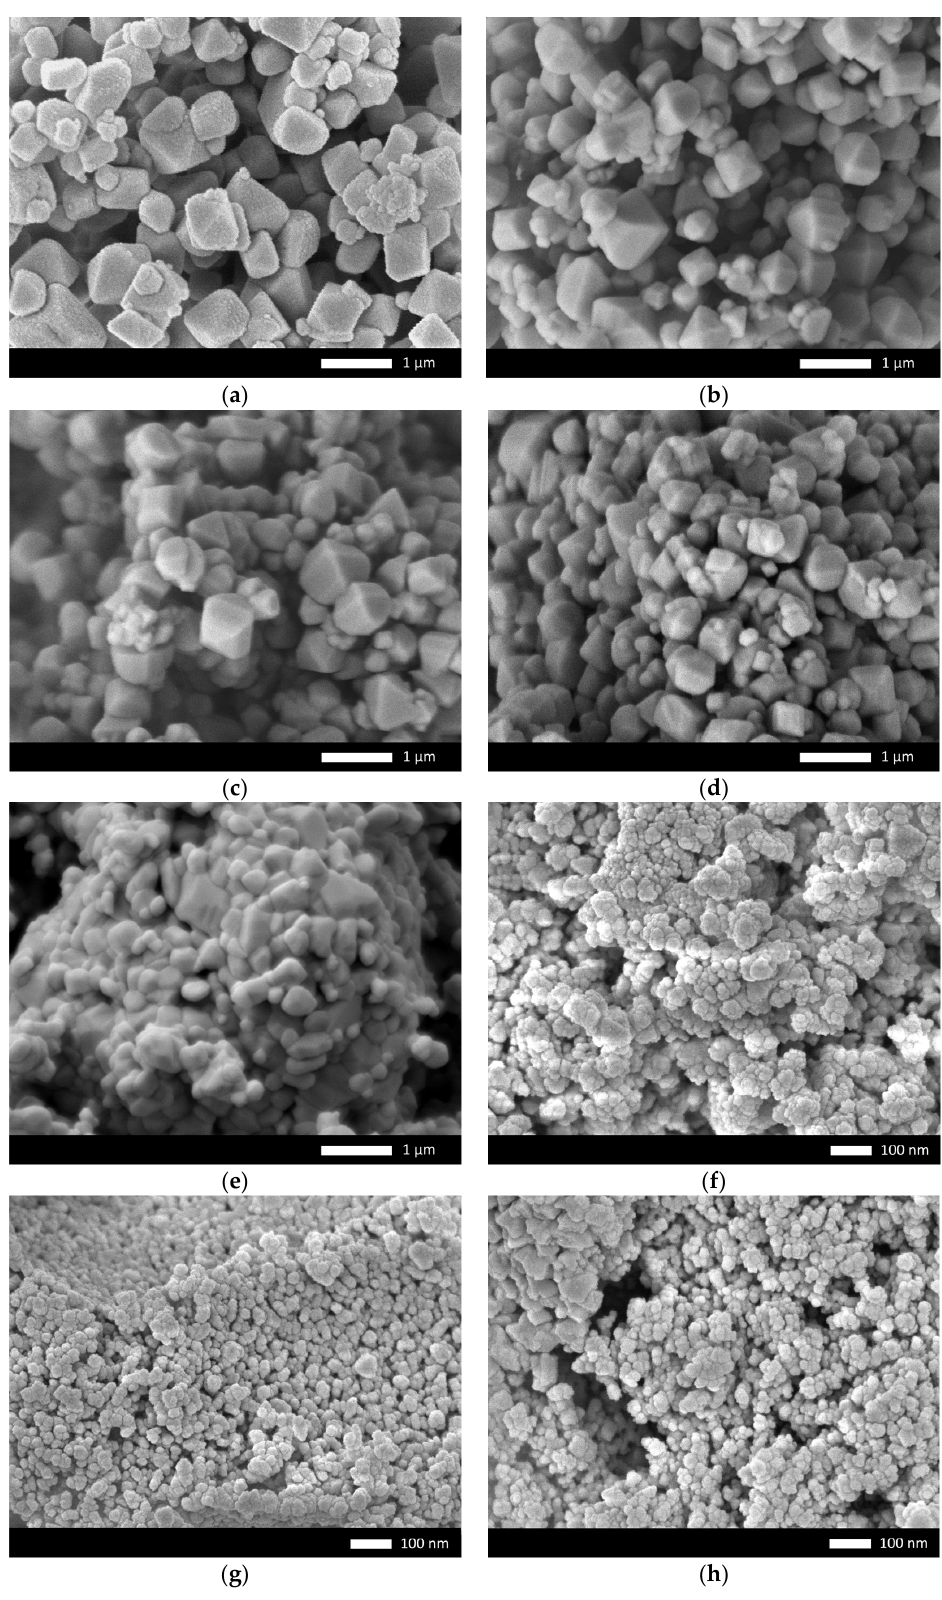
Figure 3. SEM images of the obtained ceramics depending on the grinding speed: ( a ) 250